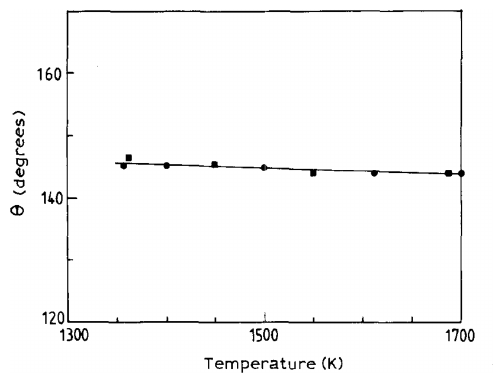
Figure 2: Contact angle, θ , of the (Cu-12.6 at% Ti) alloy on the glassy carbon substrate as a function of time at 1350K.